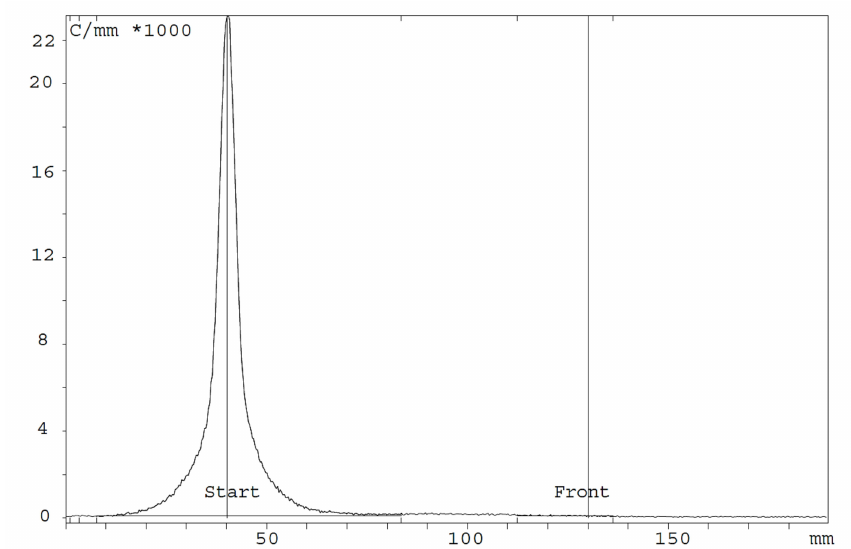
Figure 1. Radio–TLC example of [ 64 Cu]Cu-1C1m-Fc. The radiochemical purity (RCP) is 99.85%. [ 64 Cu]Cu-1C1m-Fc remains at Rf = 0, and the unbound [ 64 Cu]Cu-EDTA migrates to the solvent front. With the used radiolabeling process, the average radiochemical purity was 99.5 ± 0.6% immediately after radiolabeling ( n = 5) and 98.3 ± 2.1% ( n = 3) after 24 h. The specific activity was comprised between 156 and 200 MBq/mg.